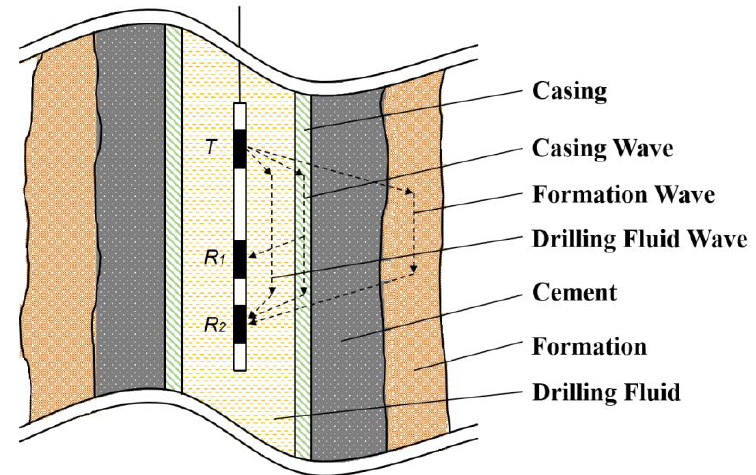
Figure 1. Schematic diagram of CBL-VDL.